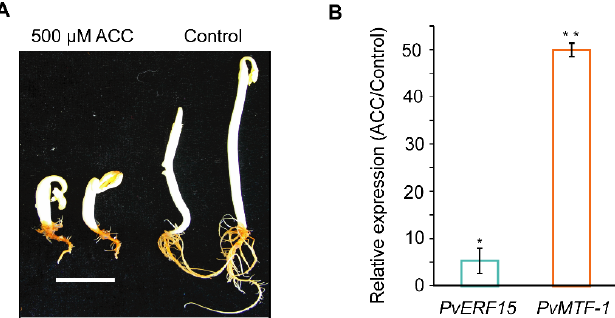
Figure 4. ACC regulates the mRNA levels of both PvMTF-1 and PvERF15 in bean seedlings. ( A ) Bean seeds were germinated and grown on the MS without (control) or with 500 μM ACC for 10 days in the dark. ACC induced a typical ethylene-responsive phenotype, indicating the effects of ethylene stress. Bar = 1 cm. ( B ) The etiolated bean seedlings were subjected to quantitative reverse transcription qRT-PCR analysis. ACC-induced expression level of PvERF15 or PvMTF-1 was expressed as a ratio relative to control, which was set to a value of 1. Data shown are averages of three independent qRT- PCR experiments. Error bars represent SEs. Significance between experimental values was assessed using one-sided Student’s t test (*, p ≤ 0.05, and **, p ≤